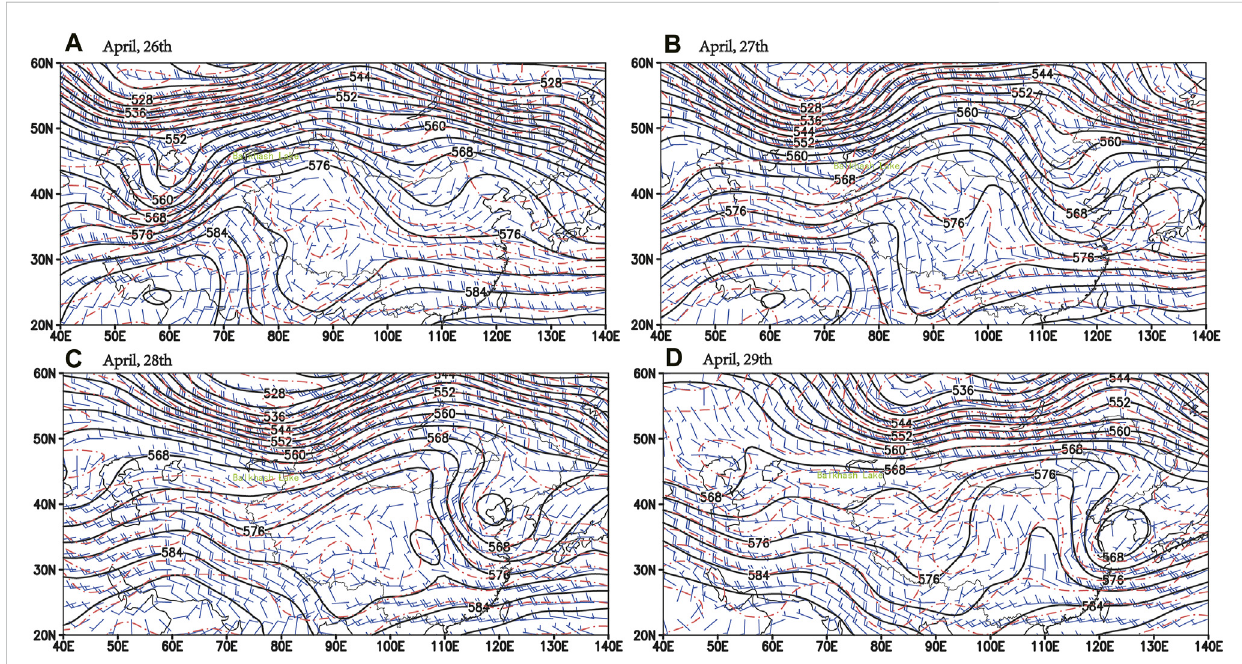
FIGURE 6 500 hPa potential height fi eld (black contour lines, unit: dagpm), temperature fi eld (reddashed line, unit: ° C), and wind fi eld (blue vector, unit: m · s -1 ) during April 26 – 29, 2015 [ (A) April 26th; (B) April 27th; (C) April 28th; and (D) April 29th].